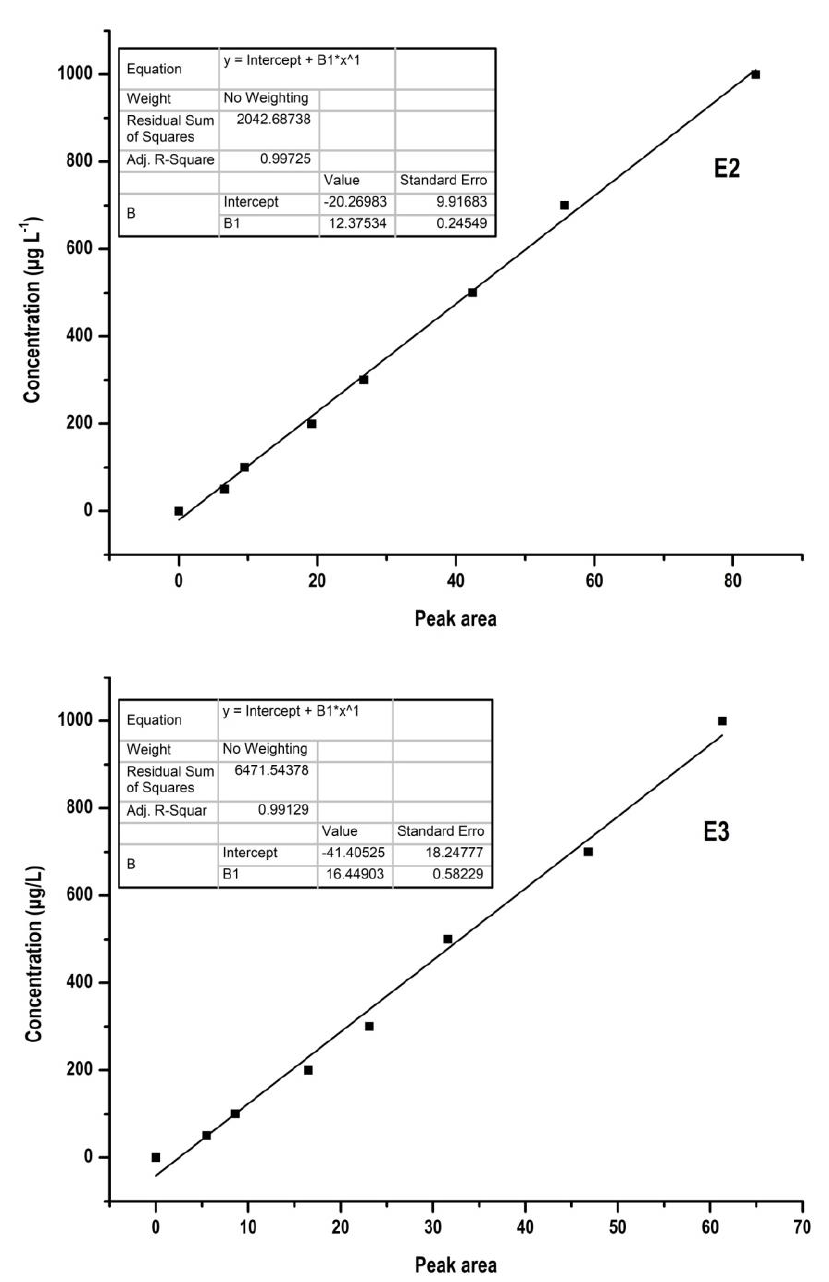
Figure 4. Standard curve of ( a ) 17β-E2 and ( b ) E3 in HPLC.